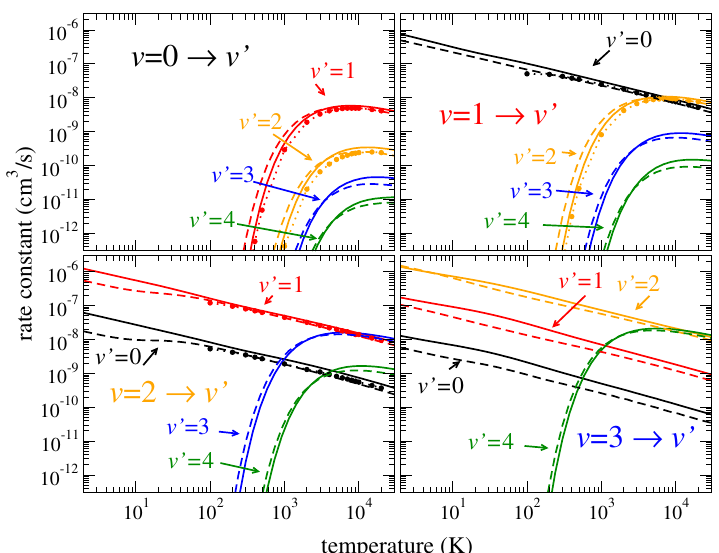
Figure 2. Examples of thermal rate coefficients for vibrational transitions in 4 HeH + (solid lines) and 4 HeD + (dashed lines). Results of a previous calculation [17] are shown by dotted lines with circles.